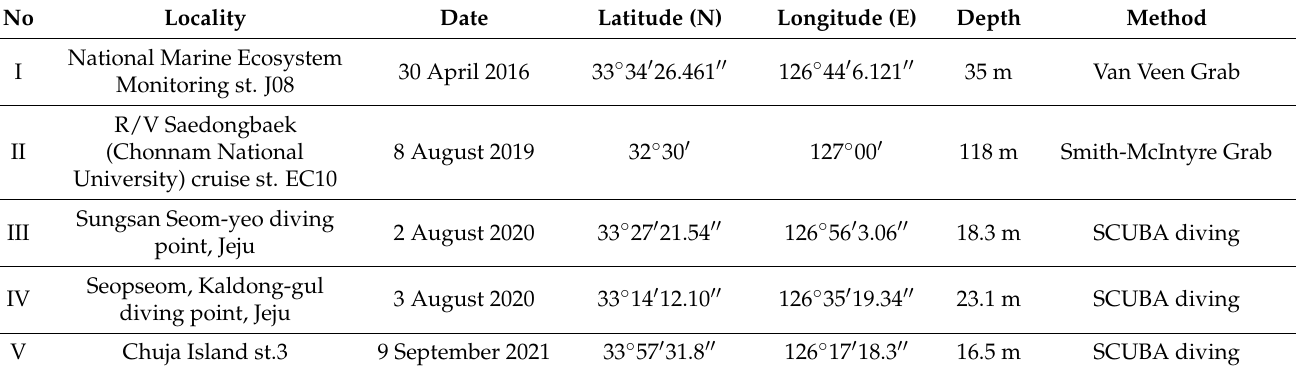
Figure 1. Map of sampling sites around Jeju Island. This map is made with QGIS software v.3.16. Table 1. Information on the sample collection